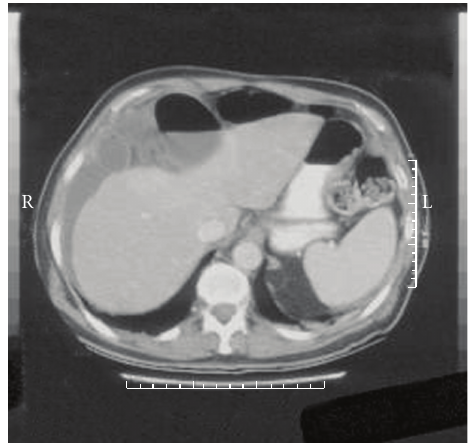
Figure 2: Representative section from the patient’s abdominal CT scan. Dilated, fluid-filled loops of small and large bowel are noted anterior and superior to the liver, along with free fluid.